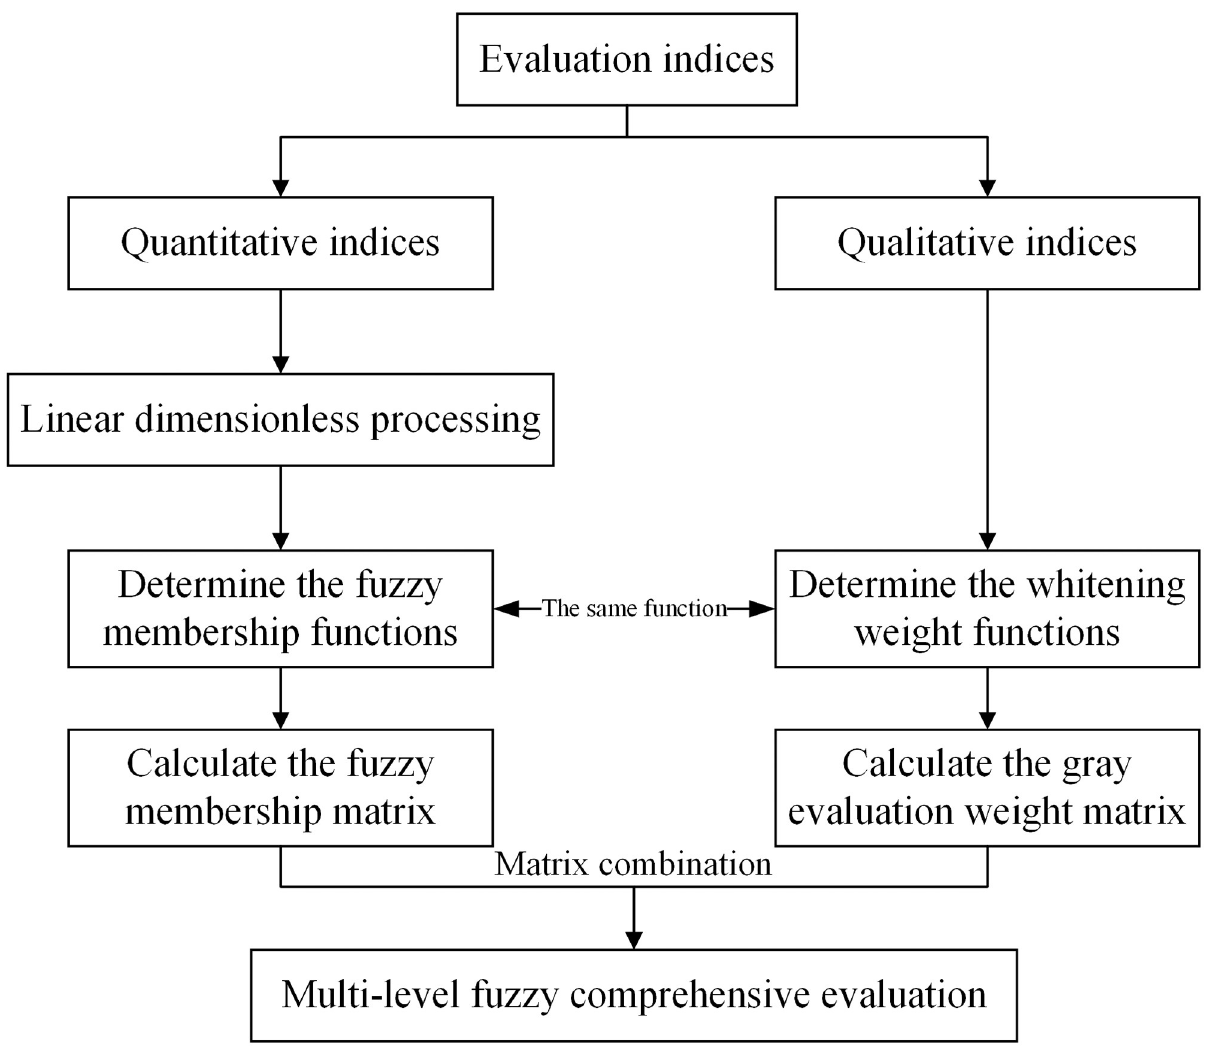
Fig 3. The roadmap of gray fuzzy comprehensive evaluation